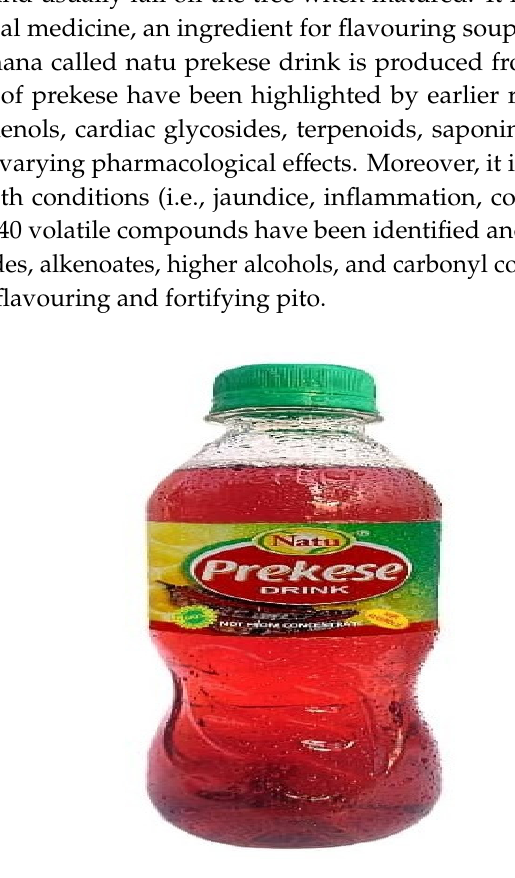
Figure 1. Local drink produced from Tetrapleura tetraptera [17].